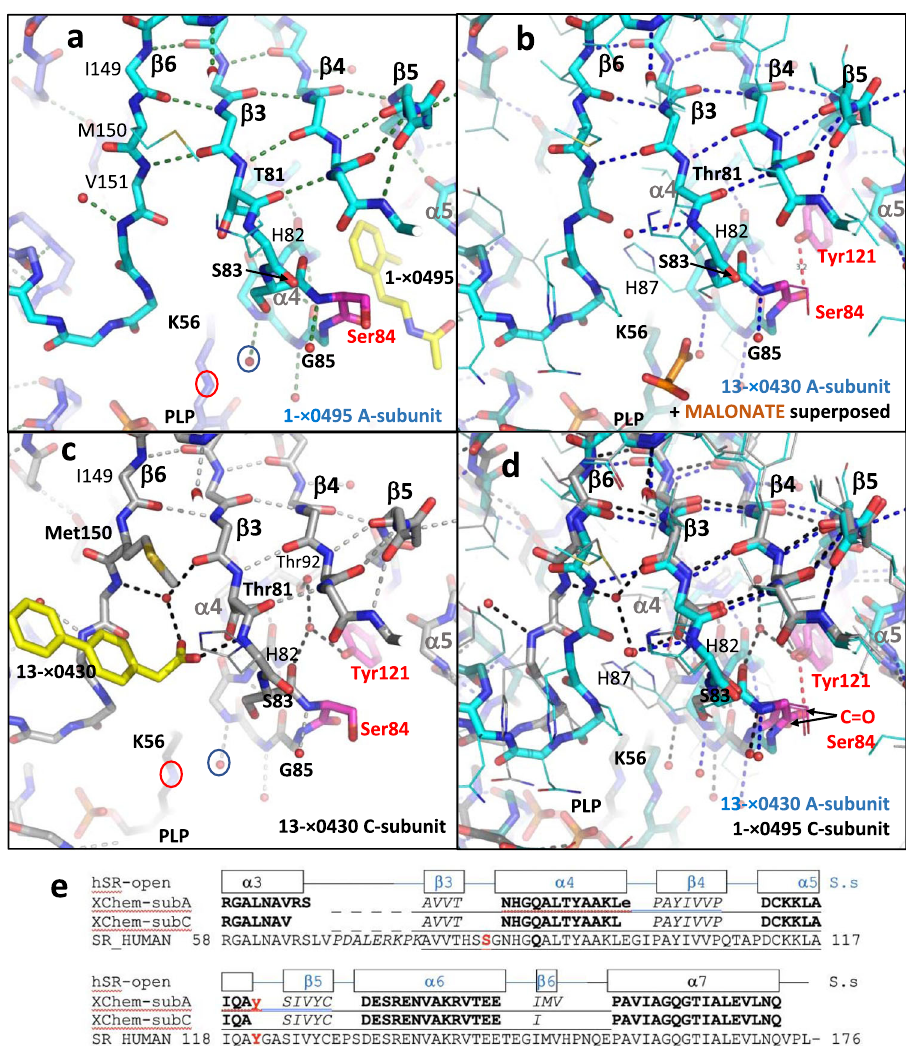
Fig. 5 XChem compounds 1-x0495 and 13-x0430 bind to different open conformations of the small domain. a View of the central β -sheet region of the A-subunit small domain in the 1.53 Å crystal structure of hSR with 1 -x0495 (7NBG; yellow carbons). All main-chain atoms are shown in stick (cyan/blue carbons) with selected side-chains shown in line (H82, M150) or stick (T81, S83). The catalytic residue Ser 84 is highlighted (magenta carbons). A water (small red sphere) and the nitrogen linking Lys 56 to the PLP are ringed. Hydrogen bonds (<3.3 Å) are shown as dotted lines. b Equivalent view of subunit A from the 1.71 Å structure with compound 13 -x0430 (7NBC) with all side-chains shown as lines. A 3.2 Å hydrogen bond (dotted red line) links the side- chain hydroxyl of Tyr 121 (magenta carbons) to the main-chain carbonyl oxygen of Ser 84. Compound 13 -x0430 is not observed in subunit A; malonate is superposed on 7NBC from the α 4 helix of the ATP-malonate structure (6ZSP). c Equivalent view of subunit C from the 1.71 Å 13 -x0430 structure (7NBC). The carboxylate group of the compound accepts hydrogen bonds from a water, the side-chain hydroxyl of Thr 81, and the main-chain NH of His 82. Note Tyr 121 (magenta carbons) forms a hydrogen bond with a water that donates a hydrogen bond to the main-chain carbonyl oxygen of Ser 83. d Equivalent view of subunit C from the 1.53 Å 1 -x0495 structure (7NBG; grey carbons) and subunit A from the 1.71 Å 13 -x0430 structure (7NBC; cyan carbons) with all side-chains shown as lines. No compound is observed in either subunit. Note different positions of Ser 84 carbonyl oxygens (arrowed). e Sequence alignment showing different lengths of the β 6-strand (149 – 151 or 149) in A and C subunits of XChem soaked